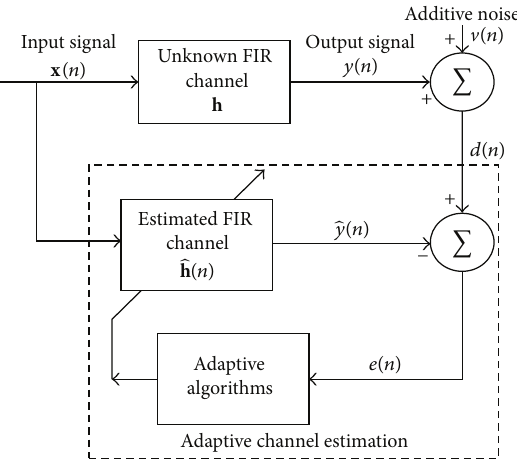
Figure 1: Typical sparse multipath communication